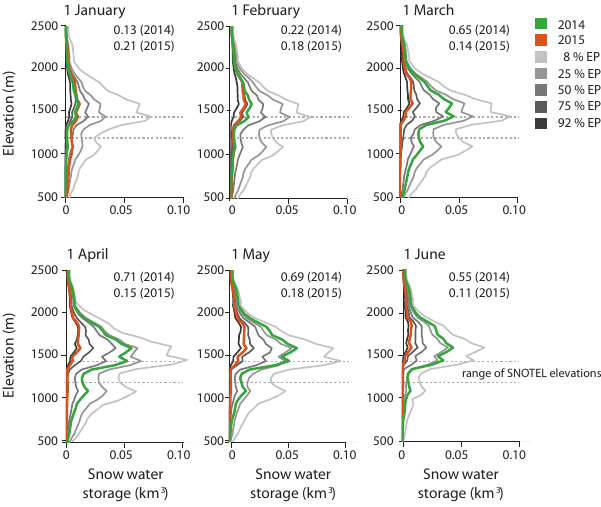
Figure 4. Volumetric snow water storage binned by 50m elevation bands. The corresponding basin-wide snow water storage (km 3 ) for 2014 and 2015 is provided for each month. Larger snowpacks (lower exceedance probability) have considerable contributions be- tween 1000 and 1300m. During 2014 and 2015, this elevation range had minimal snowpack, despite close-to-normal precipitation. Note that, on the vertical axes, snow water storage below 500 and above 2500m is not included for visual clarity. These elevations contribute minimally to basin-wide snow water storage. The calculations are 5-day averages centered on the first day of each